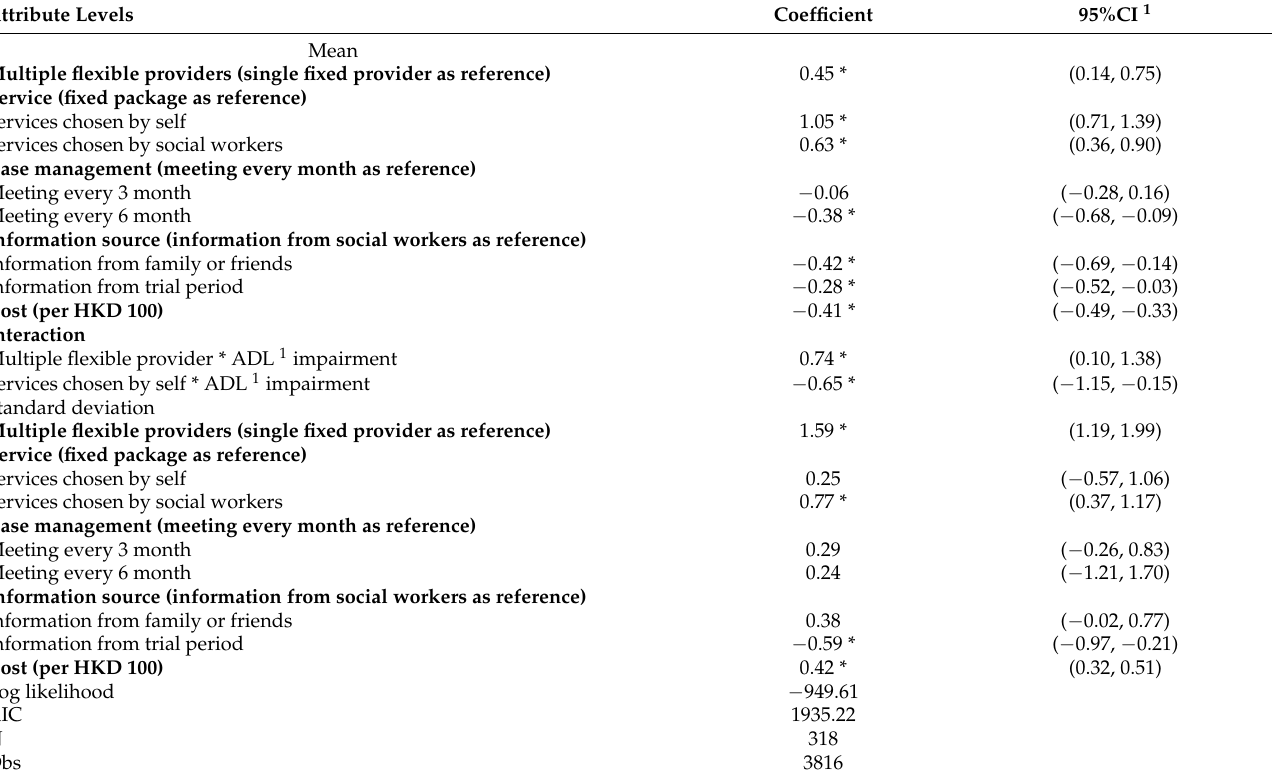
Table 5. Willingness to pay (HKD) in different subgroups of the